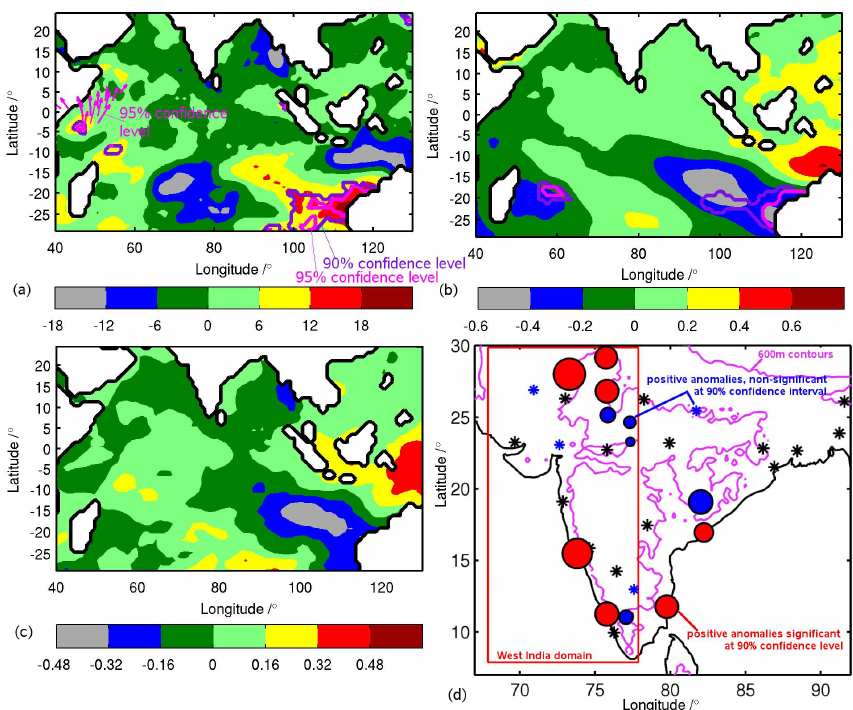
Fig. 7. (a) Composite for 1978, 1981, 1983, 1986, 1990 of anomalies of sea surface evaporation rate (cmyr − 1 , shaded), 10m-wind anomalies (arrows) (b) Same but for specific humidity at 2m height (gkg − 1 ). (c) Same but for SST (K). (d) Mean anomalies of seasonal mean daily rainfall for 1978, 1981, 1983, 1986, 1990, normalized to the climatological standard deviation, s , of each rain gauge. Radius of circles are proportional to the mean anomalies (0.5–1.0 s ). Where the circle becomes too small to be clearly visible ( < 0 . 15 s ), it is replaced with an blue asterisk. Black asterisks mark stations that do not have a positive